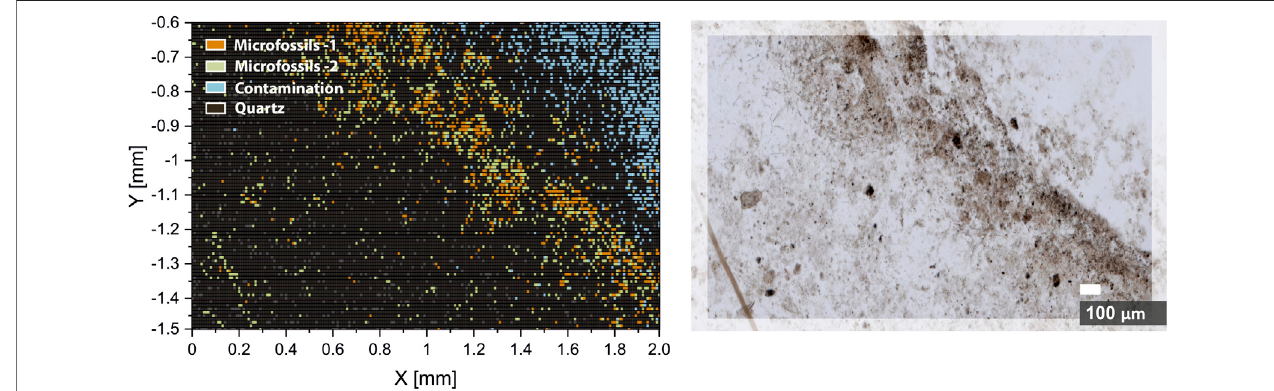
FIGURE 6 | Hierarchical density-based spatial clustering (HDBSCAN) of six UMAP components of the imaging dataset (left panel). The orange pixels represent spectra registered from the type-1 microfossils. The green pixels represent spectra registered from the type-2 microfossils. The blue pixels represent spectra registered from the surface contamination. Black and grey pixels – spectra registered from the quartz matrix of the Gun fl int chert. Right panel – the optical microscopy image of the analyzed area. Note the aligned distribution of classi fi ed spectra with the bio-lamination surface crossing the